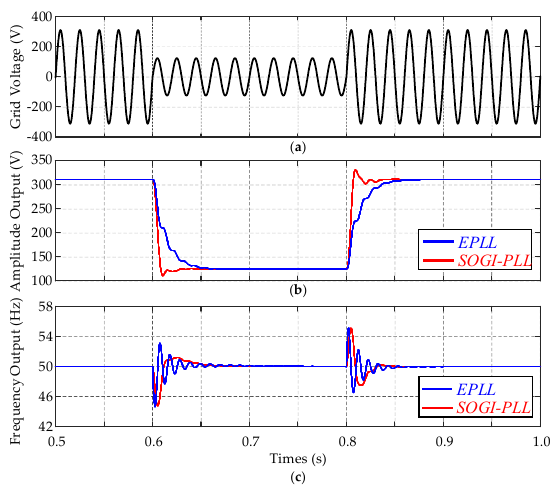
Figure 6. Performance comparison of the selected PLLs under a grid voltage fault with a 0.6 p.u. voltage drop: ( a ) grid voltage; ( b ) PLL estimated voltage amplitude output; ( c ) PLL estimated frequency output.